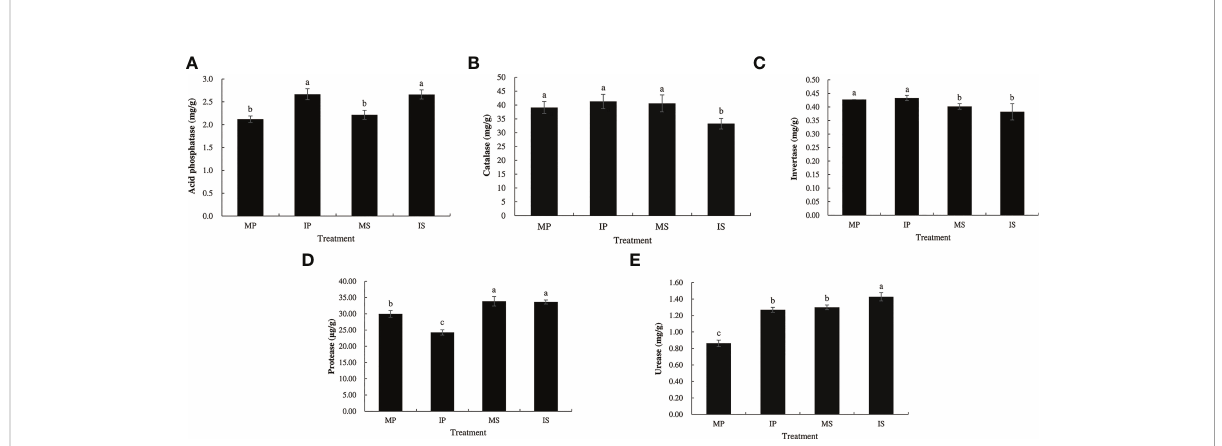
FIGURE 2 Five enzyme activity of rhizosphere soil in different planting patterns. MP, MS, IP and IS represent monoculture peanut, monoculture sugarcane, intercropping peanut and intercropping sugarcane, respectively. (A) Acid phosphatase; (B) catalase; (C) invertase; (D) protease; (E) urease. Six biological replicates were used in this experiment, and same letters represents not signi fi cantly different (S-N-K ’ s test, a = 0.05).